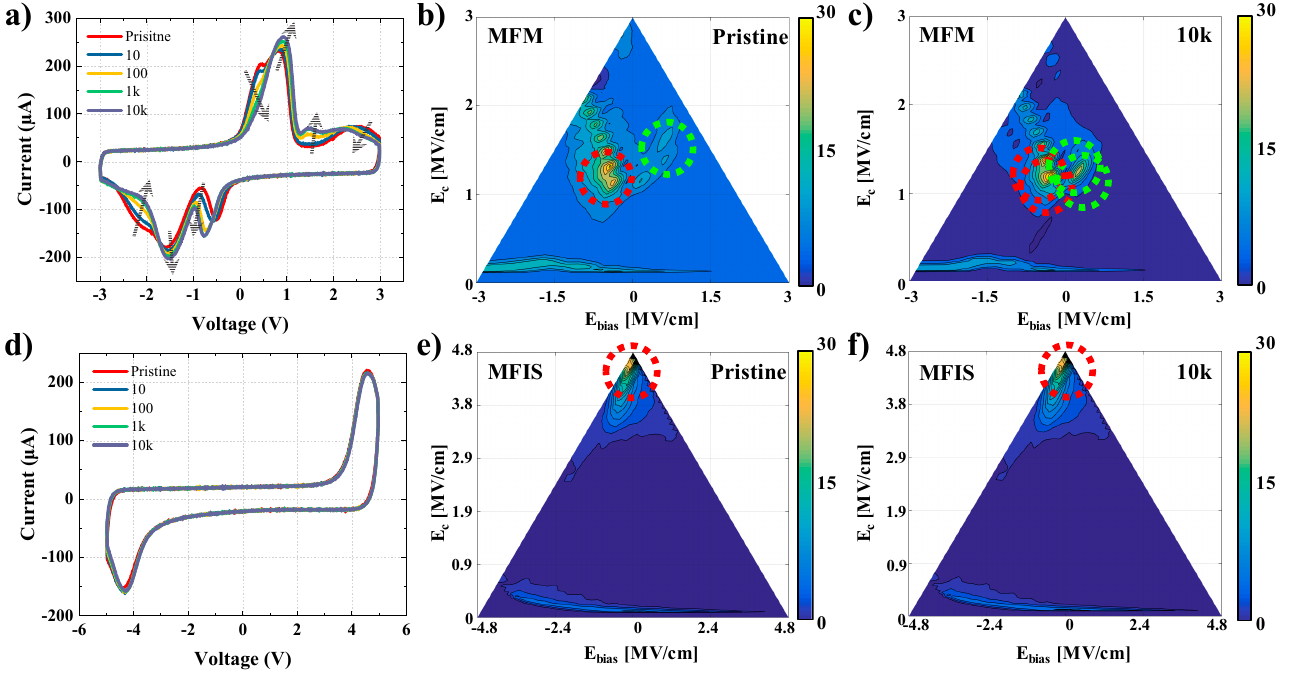
Figure 3. A comparison of the stability of the MFM and MFIS FTJ devices under electrical switching cycling: current–voltage curves of ( a ) MFM and ( d ) MFIS FTJ devices with an increase in the number of cycles; switching density pseudo-color plots ( b ), ( e ) in the pristine state, and ( c ), ( f ) after 10k switching cycles. The scale bar to the right of the graph represents the switching density, ρ .